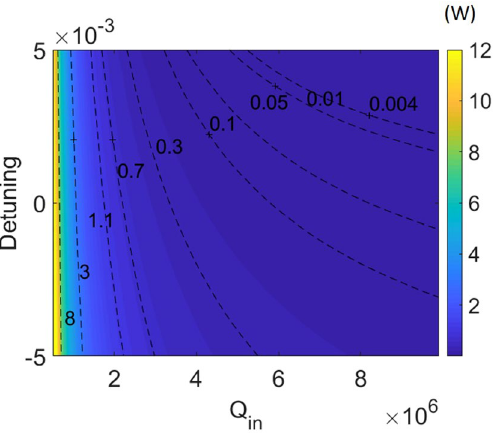
Figure 8. Color-map of the threshold power with the thermal induced shift γ T = 10 γ